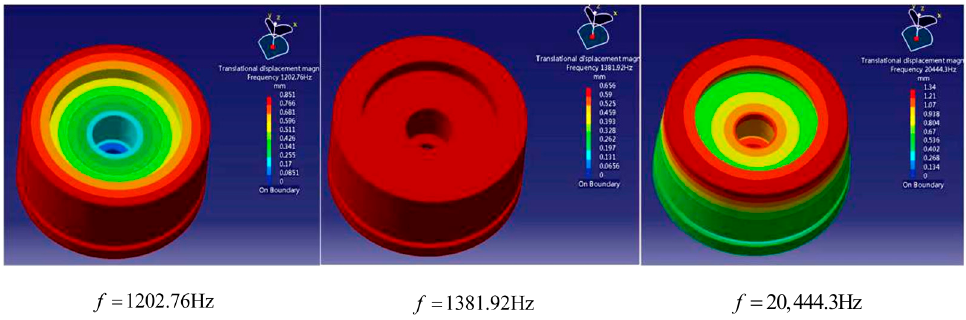
Figure 7. The first three order modal graphs of the sensor without fluid in the cavity.